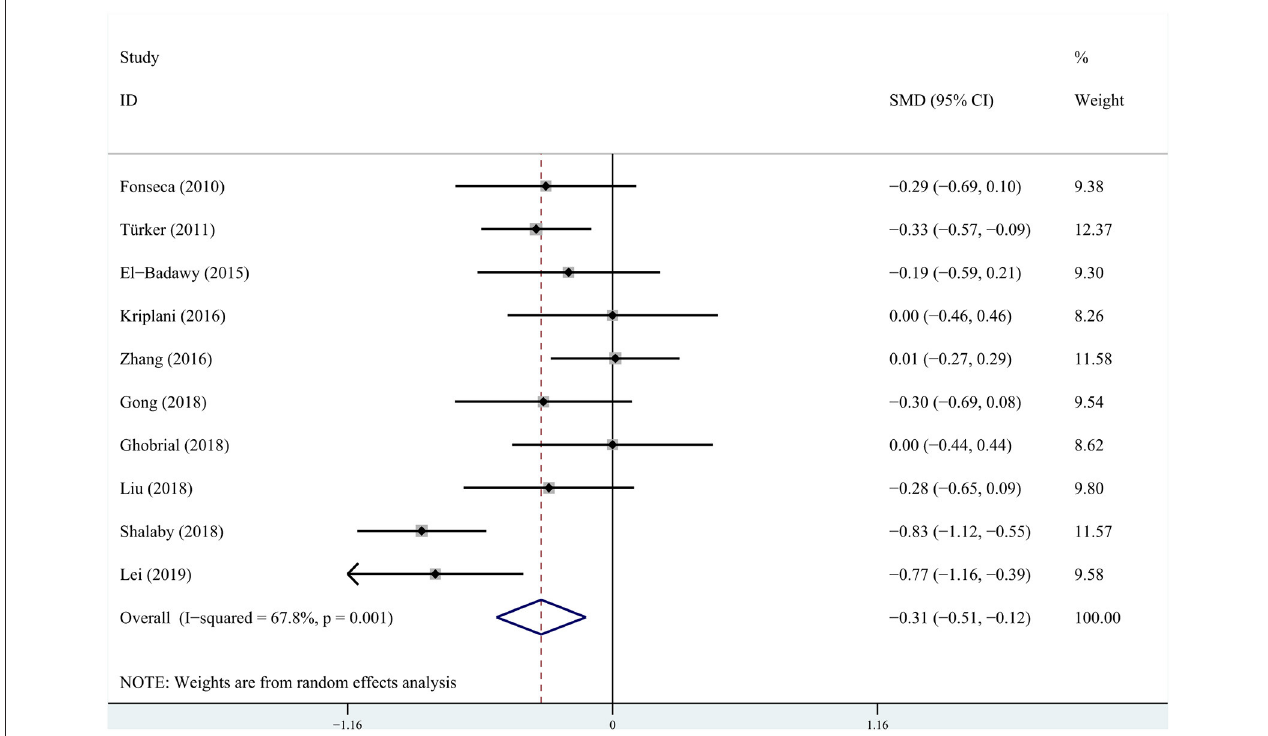
FIGURE 2 | Pooled standardized mean difference (SMD) for gestational age from random-effects meta-analysis.